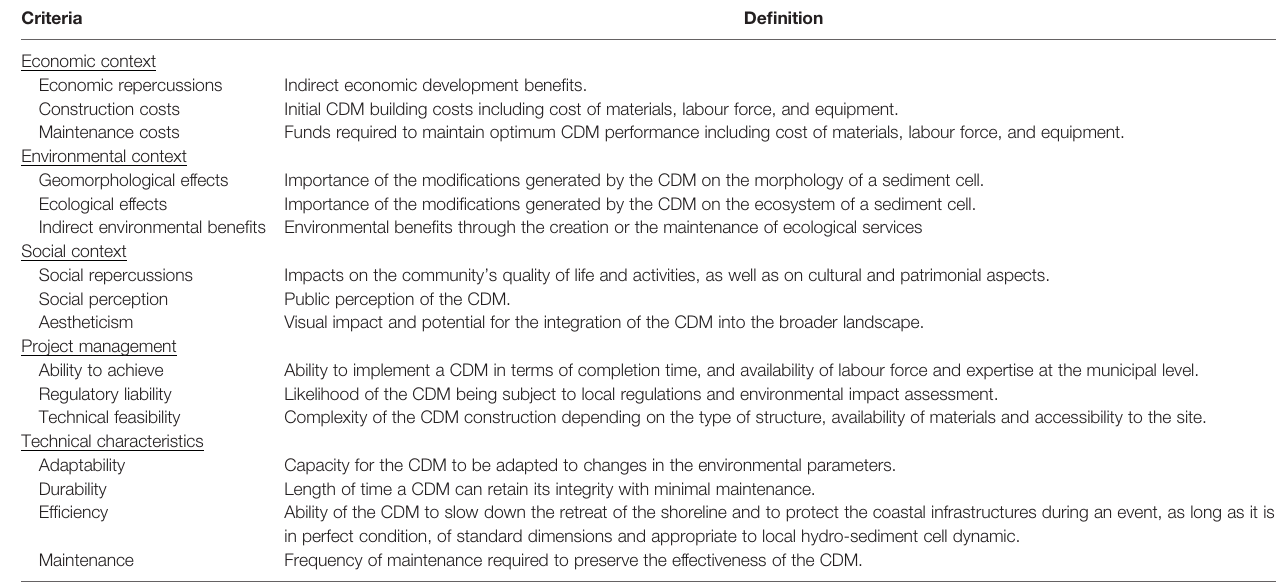
TABLE 4 | Standardized criteria identi fi ed by participants during the